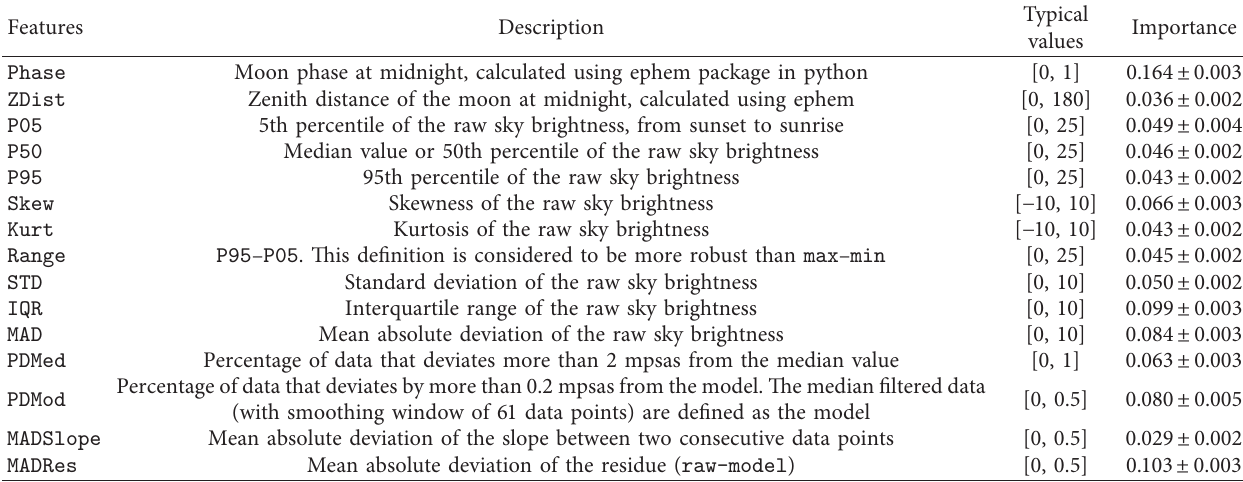
Table 2: Description of the features extracted from nightly sky brightness data. The rightmost column summarizes feature importance from Random Forest Classifier with uncertainties calculated using 10-fold